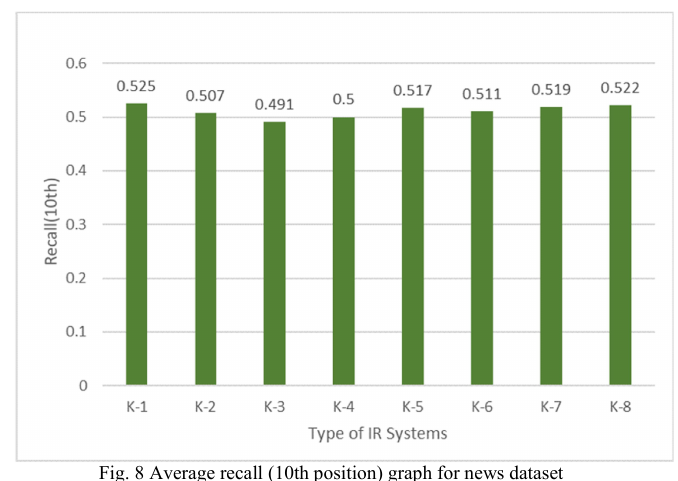
Fig. 8 Average recall (10th position) graph for news dataset